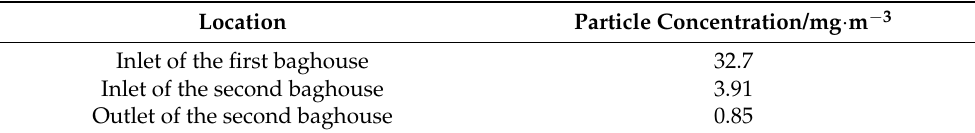
Table 1. Sampling results of particles in three